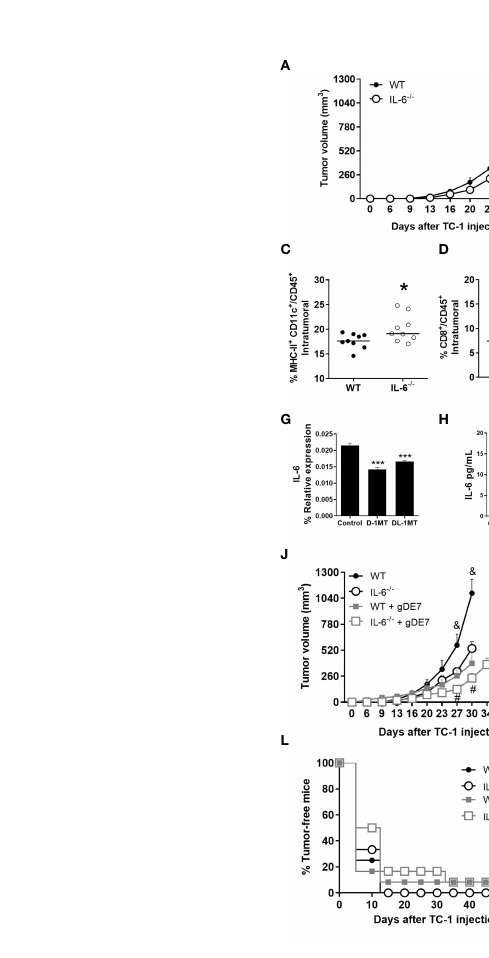
FIGURE 3 Expression of IL-6 affects immune cells and negatively impacts gDE7 antitumor effects. (A) Wild-type (WT) and IL-6 -/- mice were subcutaneously inoculated with 1 x 10 5 TC-1 cells and tumor growth was monitored until day 30 (D30) when at least 80% of the mice from each group were alive. Immune cell analyses of the tumor microenvironment were evaluated at day 21 after the tumor engraftment. (B) Frequency of CD45 + cells. (C) Frequency of CD11c high MCH-II high cells. (D) Frequency of CD8 + T cells. (E) Frequency of CD4 + T cells. (F) Frequency of FoxP3 + CD25 + T cells. Data from one experiment (n=9) were pooled and analyzed by unpaired t-test. (G , H) Effects of 1MT isoforms on the expression IL-6